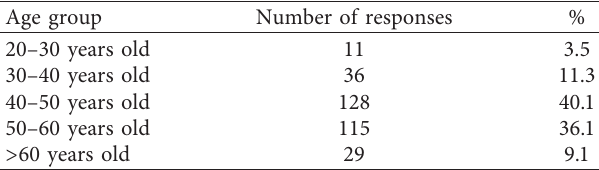
Table 3: IGSE administrators of Kharkivska oblast by age groups. Age group